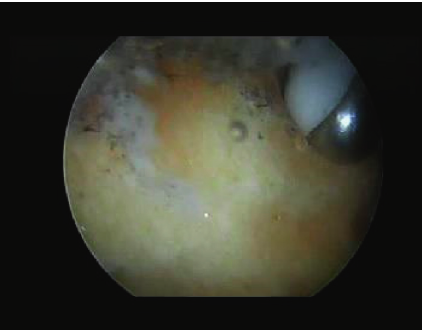
Figure 4: Clearance of the soft tissue to facilitate the resection of the bony prominence using a radiofrequency ablation